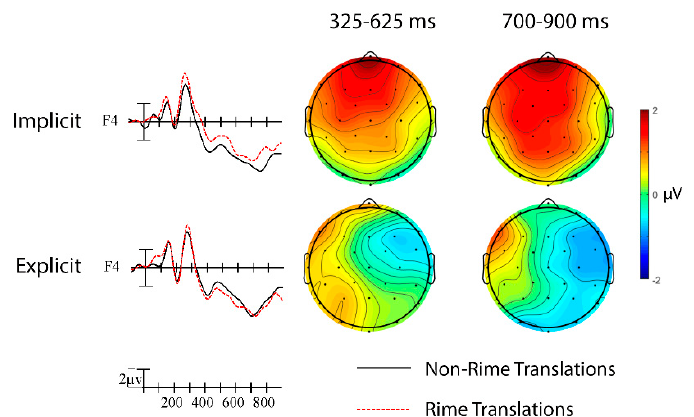
Figure 5. English translation rime effects in implicit and explicit subgroups of deaf signers at representative site F4. Scalp voltage maps showing the difference in mean amplitude between non-rime and rime translation trials for each of the analyzed time windows.